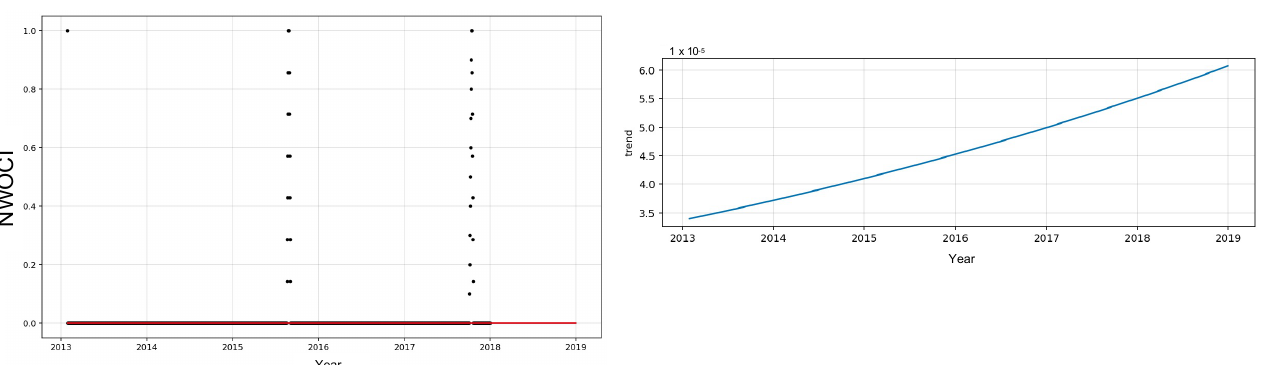
Figure A9. Left : One year forecast (2018 test data) from Prophet-BU Model for Nantucket county in MA. N.B: The solid blue line shows the average forecast while the solid red line shows the observed trend of NWOCI and the light blue region represents the 80% confidence interval for the forecast uncertainty. Also, the scatter points represent the historical values in the training data (2013–2017). Right : Corresponding trend decomposition from Prophet-BU